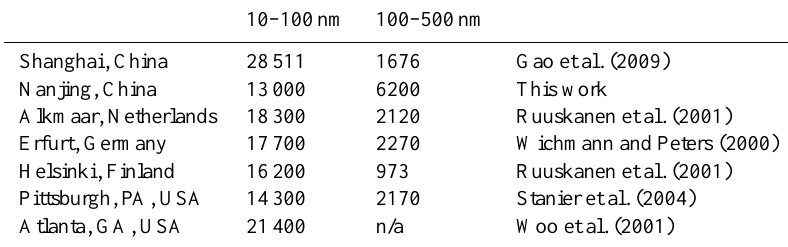
Table 4. Aerosol numbers (cm − 3 ) in Nanjing and Shanghai compared to other cities around the world.